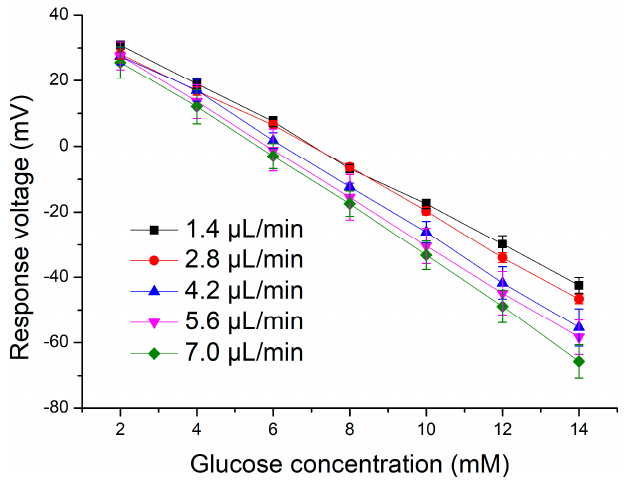
Figure 6. Response curves of the CZO sensor under different flow rates.